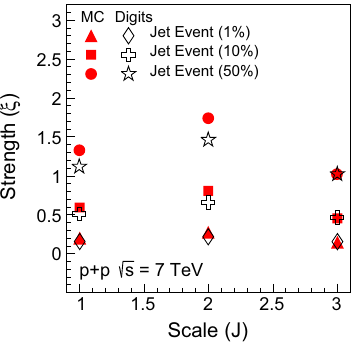
Fig. 9 Strength ( ξ ) vs. scale parameter for different jet transverse √ s = 7TeV from MC truth and energies in pp collisions at